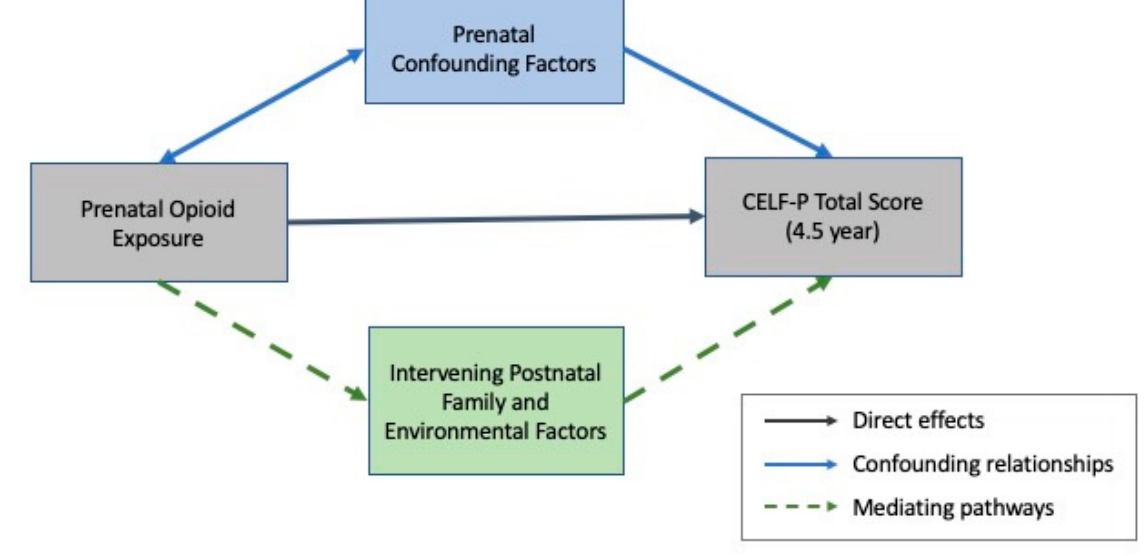
Figure 1. Hypothesized pathways.